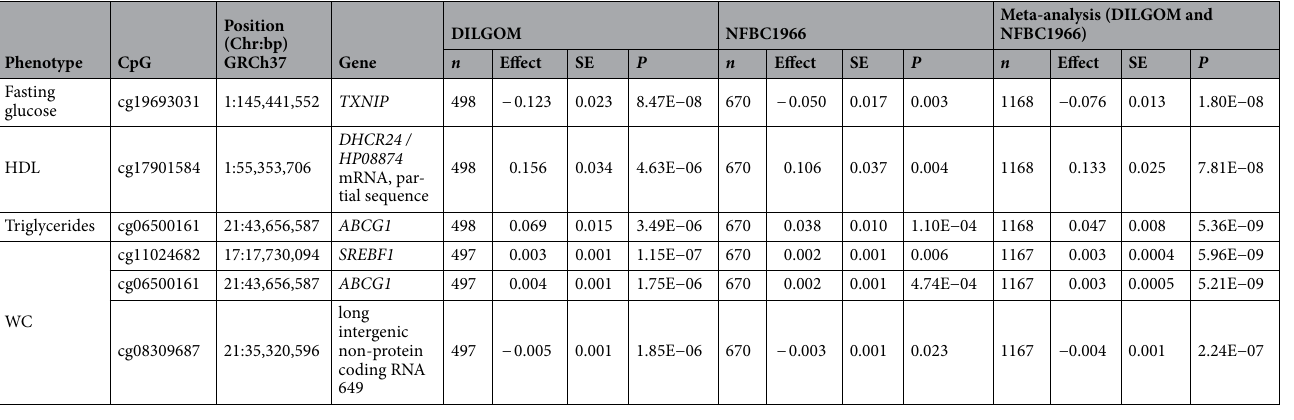
Table 3. Successfully replicated CpG M value—phenotype associations and the meta-analysis. DILGOM dietary, lifestyle, and genetic determinants of obesity and metabolic syndrome, NFBC1966 Northern Finland Birth Cohort 1966, HDL high-density lipoprotein, WC waist circumference, CpG cytosine–guanine dinucleotide, Chr chromosome, bp, base pair, GRCh37 the Genome Reference Consortium human genome (build 37), SE standard